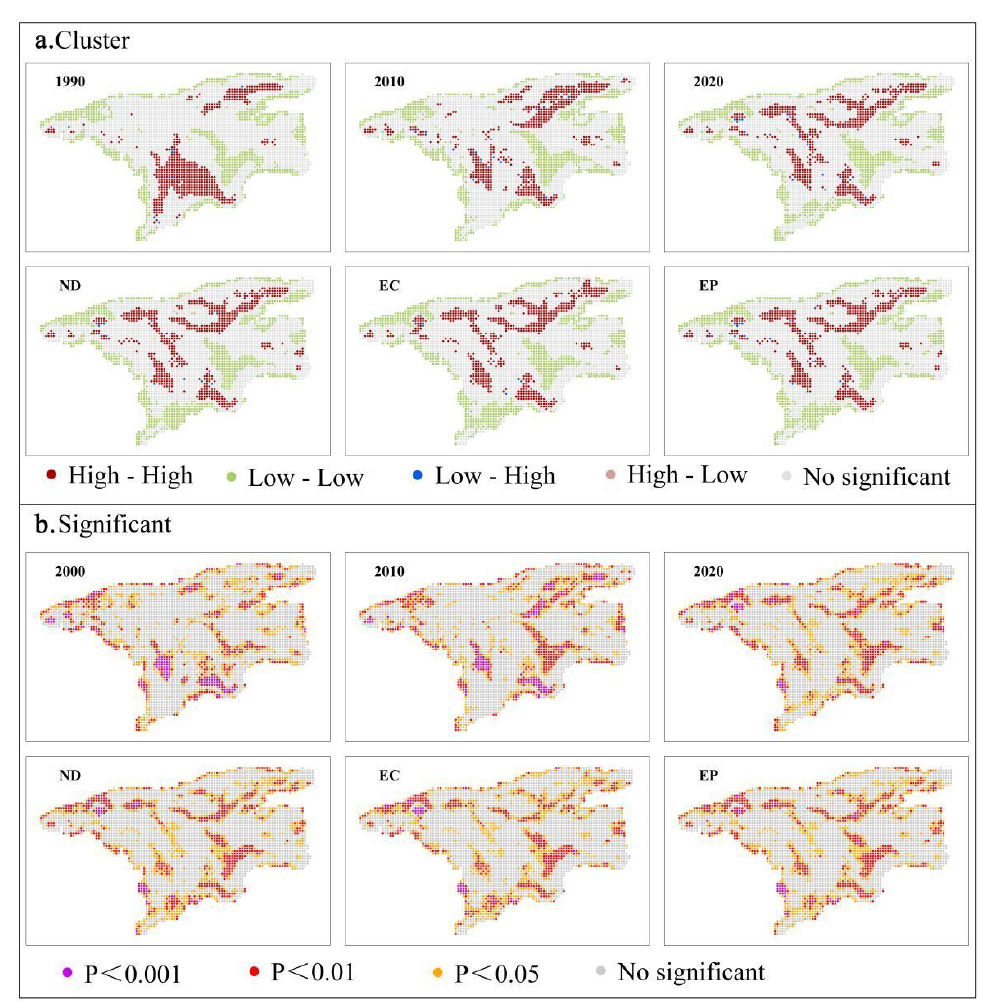
Figure 7. LISA ( a ) cluster and ( b ) significance Map. Note: ND, natural development; EC, ecological conservation; EP, economic priority.